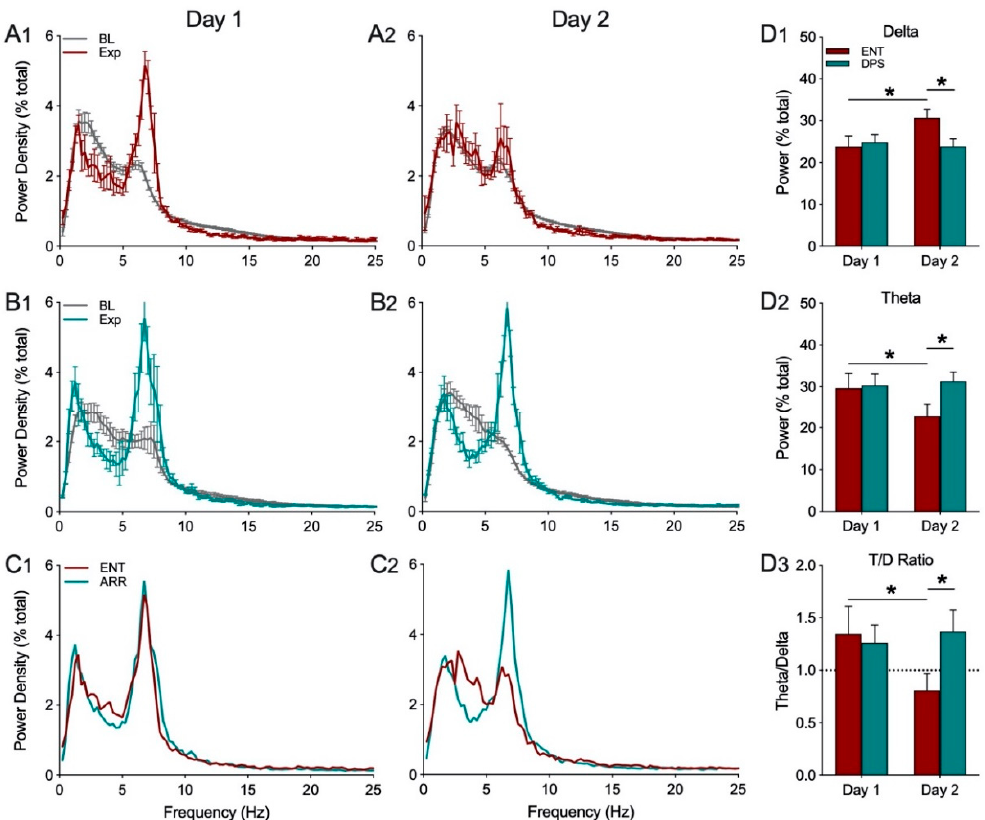
Figure 3. Mean (± SEM) spectral data recorded during baseline (BL, gray) and exploration under ENT (red) and DPS (green) conditions. All data were collected in the late afternoon from a single group of animals (n = 6). In the ENT condition, there was a robust decrease in EEG power in the delta range (0.5–4.0 Hz) with a corresponding increase in theta (5–8 Hz) power ( A1 ) that was absent 24 h later on day 2 ( A2 ). By contrast, in the DPS condition, object exploration elicited changes in both delta and theta on days 1 ( B1 ) and 2 ( B2 ). Spectral data during object exploration are shown without error bars to facilitate visual comparisons of the EEG under ENT and DPS conditions on days 1 ( C1 ) and 2 ( C2 ). Total delta power ( D1 ) increased significantly, while total theta power ( D2 ) decreased in ENT animals, on day 2 compared to day 1, leading to differences between ENT and DPS on day 2. A similar pattern was observed for the theta/delta (T/D) ratio ( D3 ). Data expressed as mean (± SEM). * indicates significant differences; see text for p values.